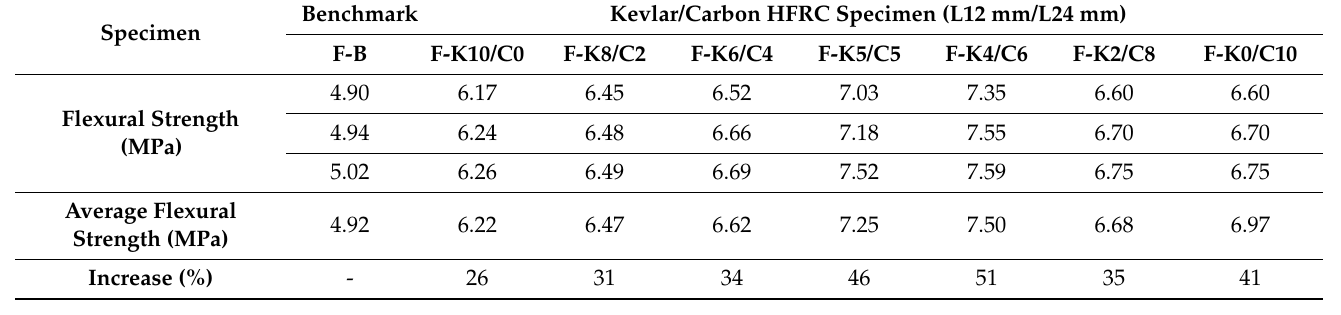
Table 6. Flexural strengths of benchmark and Kevlar/carbon HFRC specimens.